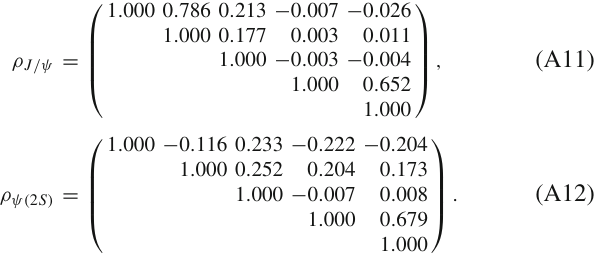
as functions of q 2 , and comparison with two a-posteriori 1